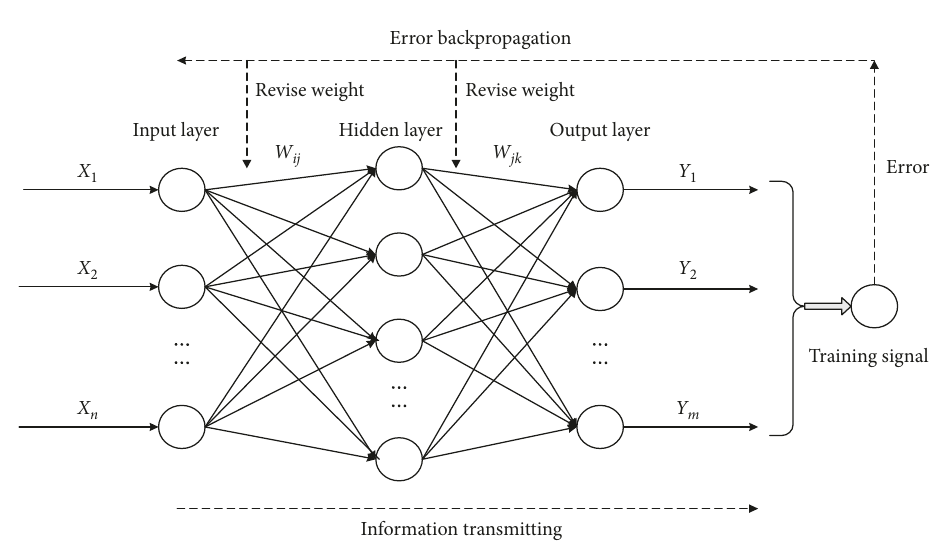
Figure 3: The BPNN model.